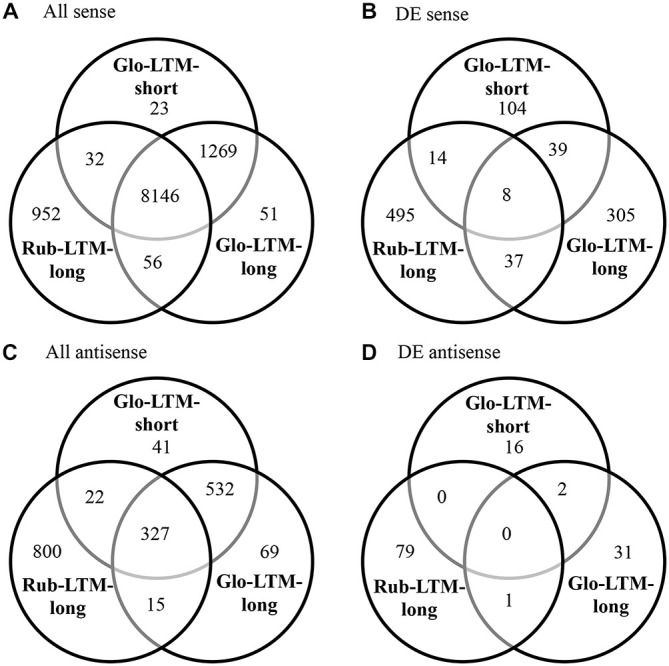
Venn diagrams of all sense (A), differentially expressed (DE) sense (B), all antisense (C) and DE antisense (D) genes in Glo-LTM-short, Glo-LTM-long and Rub-LTM-long.